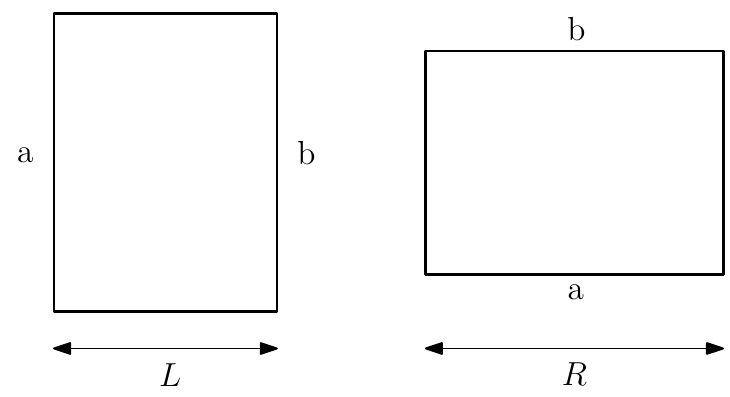
Figure 1 . Modular invariance of the annulus partition